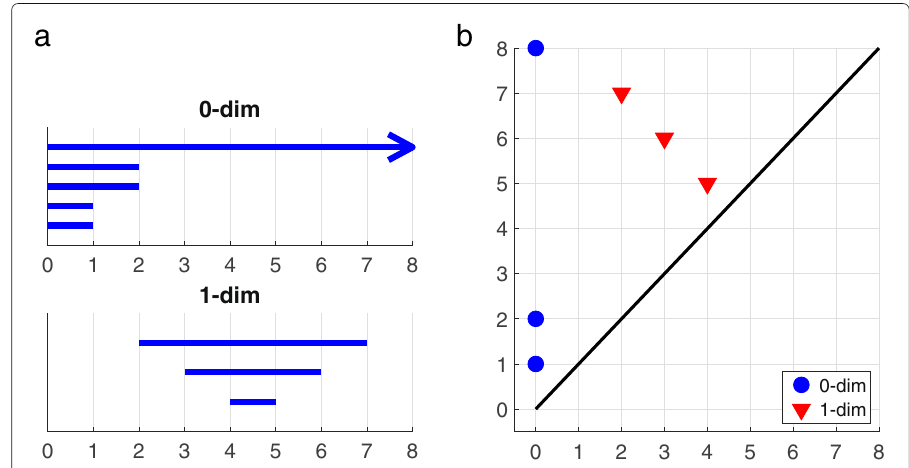
Fig. 6 Results of the filtration in Fig. 5, ( a ) Persistence barcodes for 0- and 1-dim ( b ) Persistence diagrams for 0- and 1-